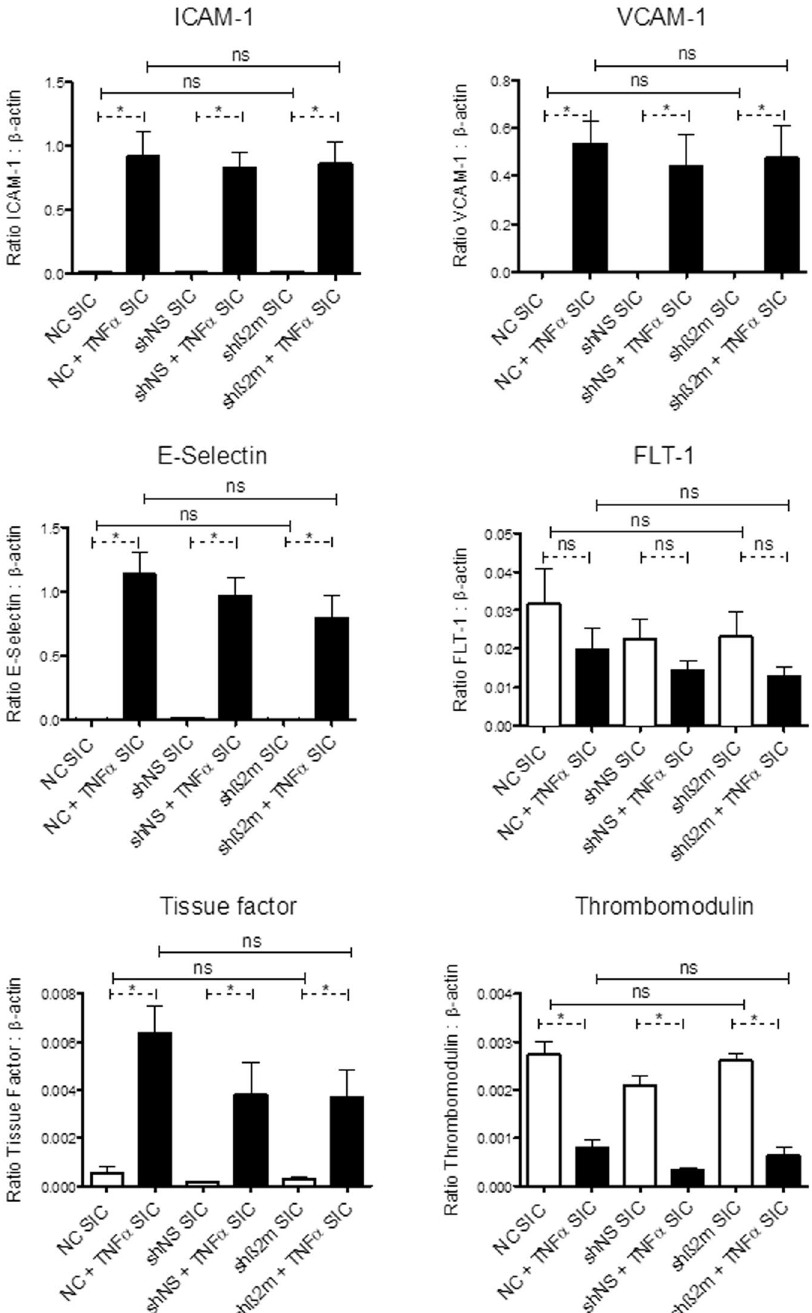
Figure 4. HLA class I-silenced ECs respond to external stimuli. RT-PCR analysis of the endothelial phenotype (FLT-1), endothelial specific activation (ICAM-1, VCAM-1, E-Selectin) and thrombogenic state markers (tissue factor, thrombomodulin) of NC, shNS and sh β 2m on SICs, with and without TNF α -stimulation indicated a stable endothelial phenotype and a physiological response to TNF α -stimulation, which is not affected by the cell-to-SIC contact, or by silencing HLA-class I expression. The paired two-tailed t-test and the one-way ANOVA analysis were used to determine statistically significant differences (p < 0.05) indicated by the asterisks ( * ). Statistically insignificant results are marked as “ns”. The results are expressed as group means ± standard deviation (n =